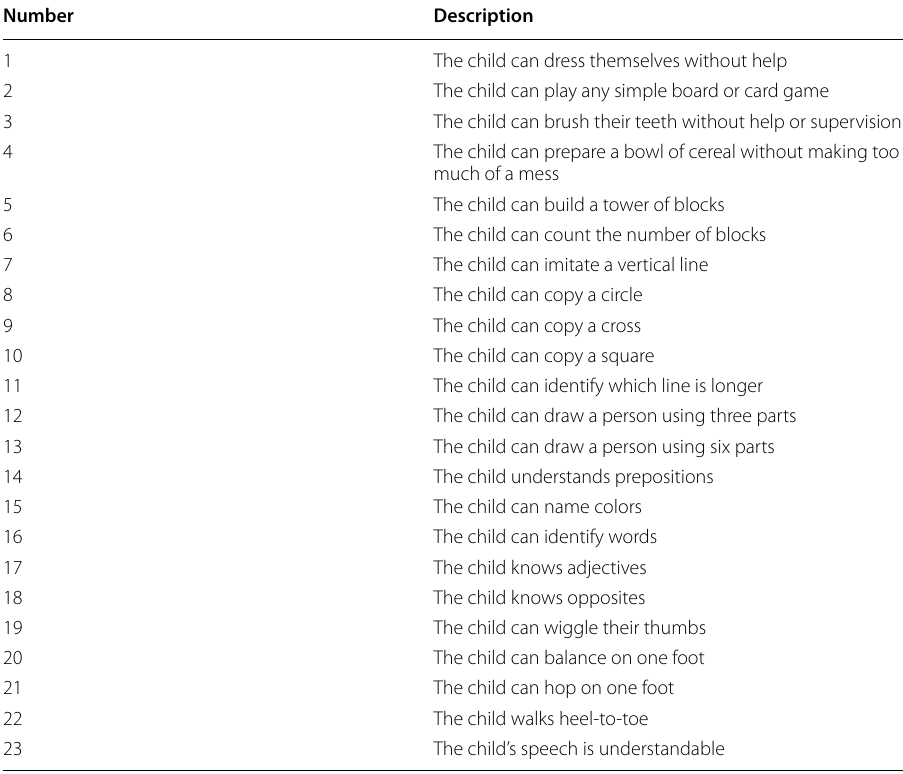
Table 1 R-DPDQ required physical, communication, and cognitive skills for five year old children Number